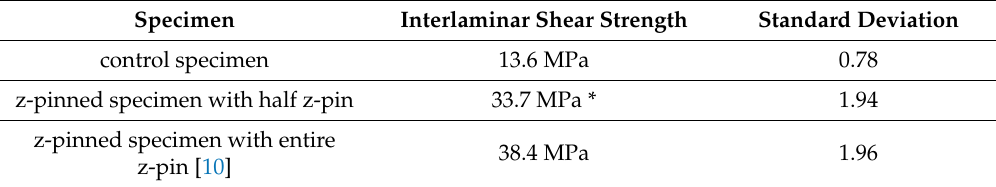
Figure 2. Typical tensile shear curves of carbon fiber-reinforced aluminum matrix composites (Cf/Al) with and without a z-pin. Table 4. Interlaminar shear strengths of controls and z-pinned specimens.